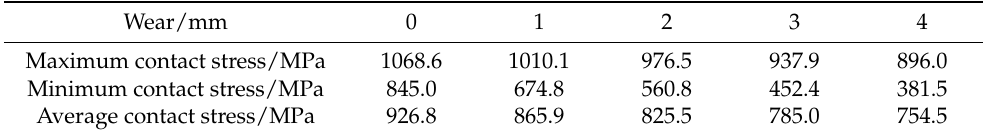
Table 5. Contact stress on circumferential